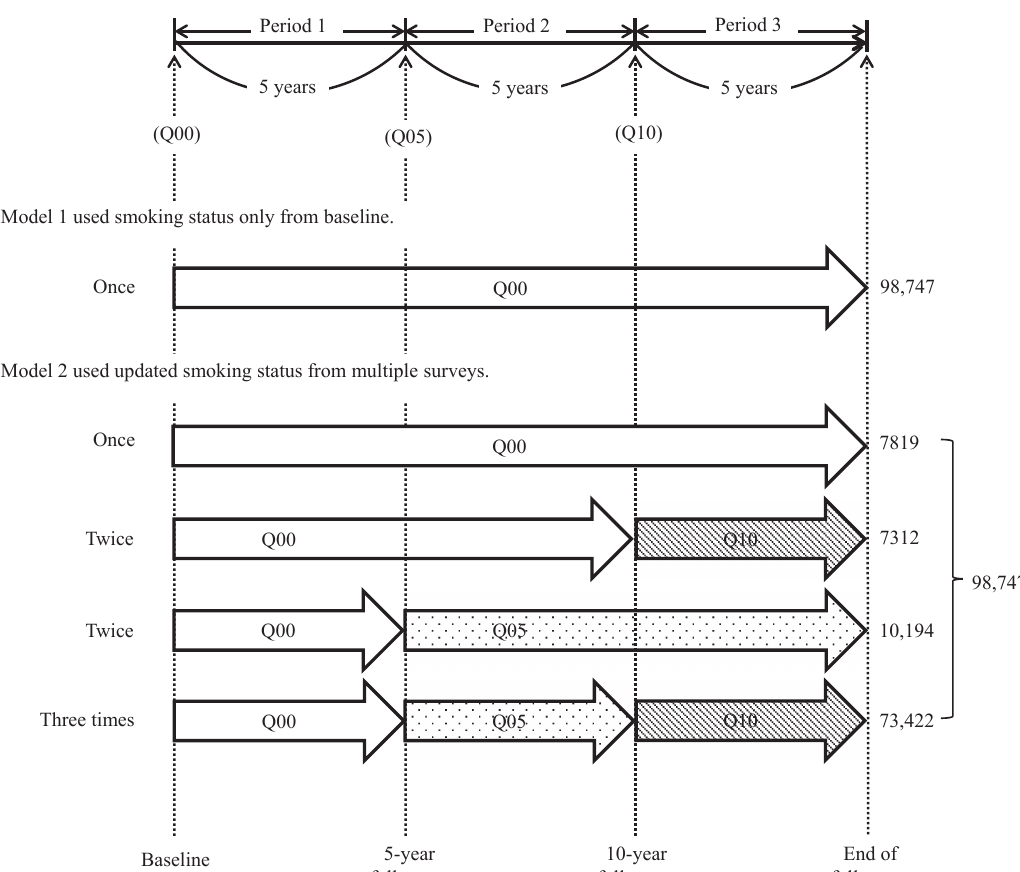
Figure 1. The timeline of